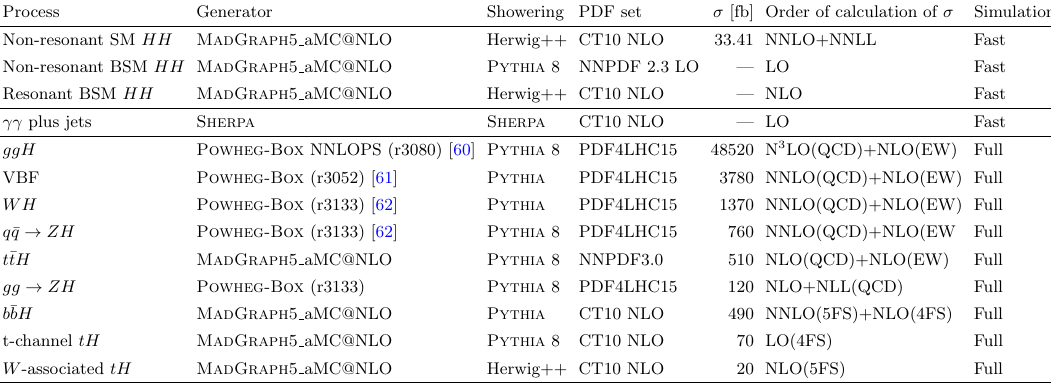
Table 1. Summary of the event generators and PDF sets used to model the signal and the main background processes. The SM cross-sections (cid:27) for the Higgs boson production processes with m H p = 125 : 09 GeV are also given separately for s = 13 TeV, together with the orders of the calcula- tion corresponding to the quoted cross-sections, which are used to normalise samples. The following generator versions were used: Pythia 8.212 [45] (event generation), Pythia 8.186 [46] (pile-up